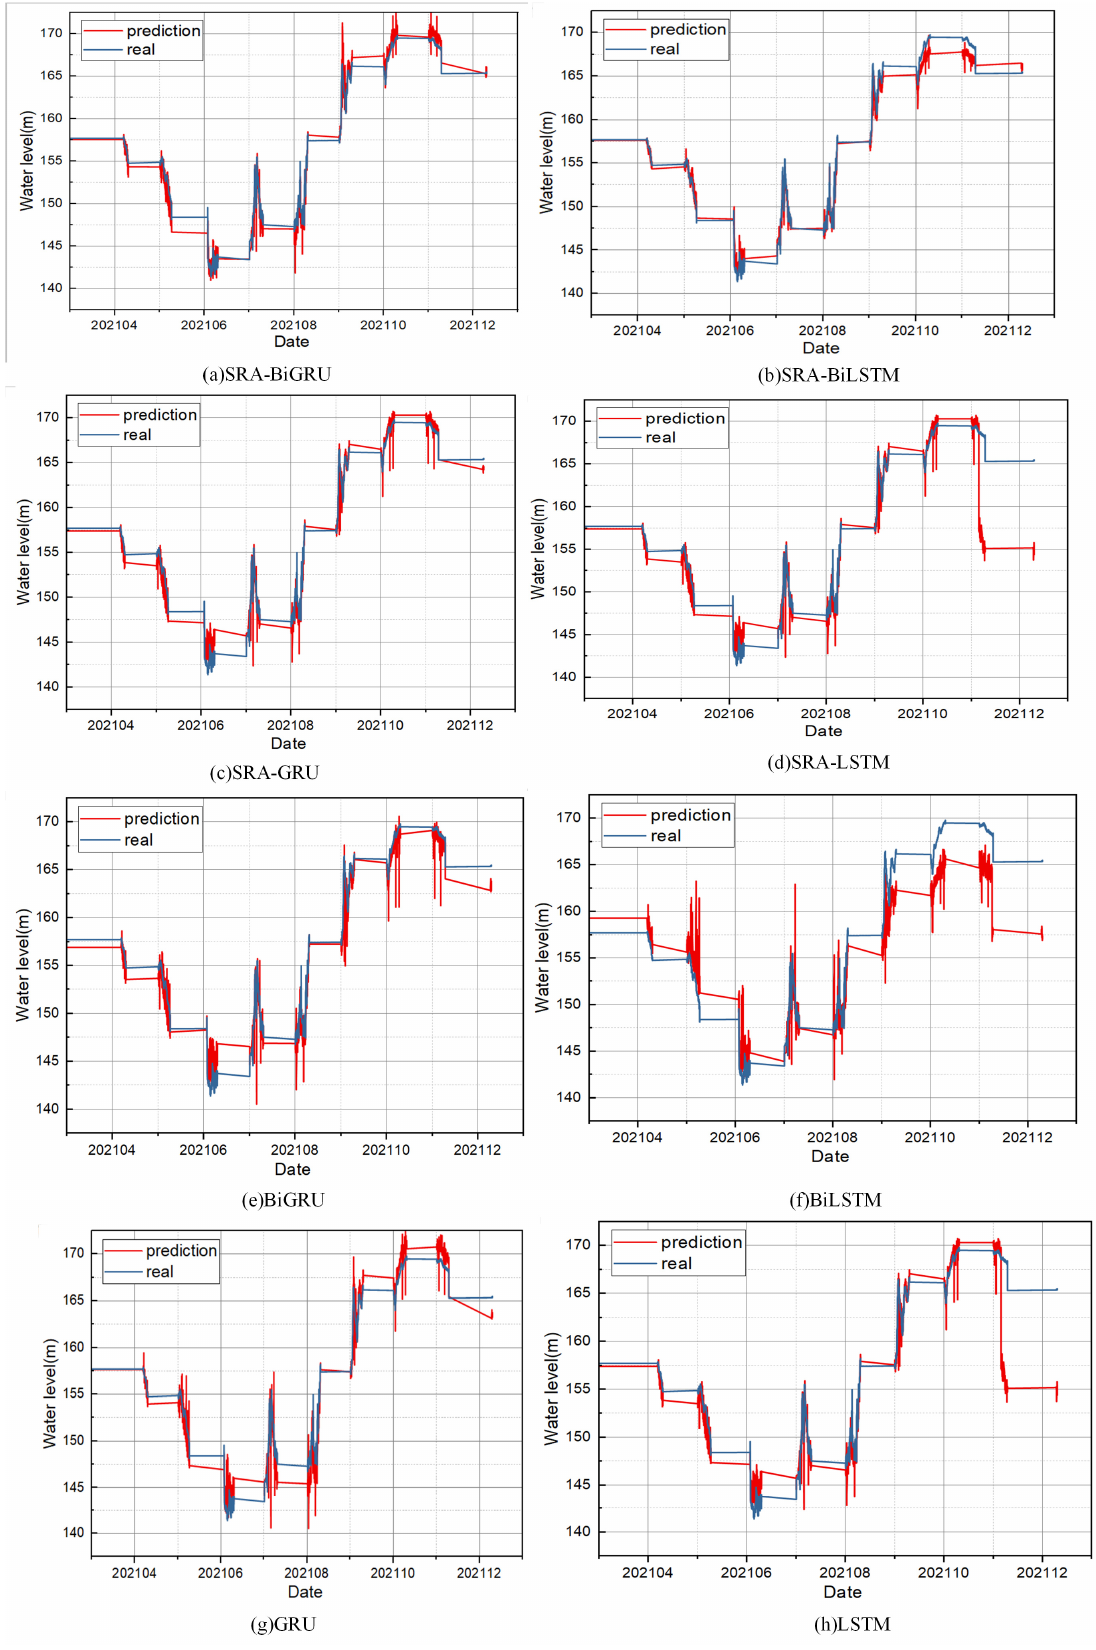
Figure 11. Water-level prediction.